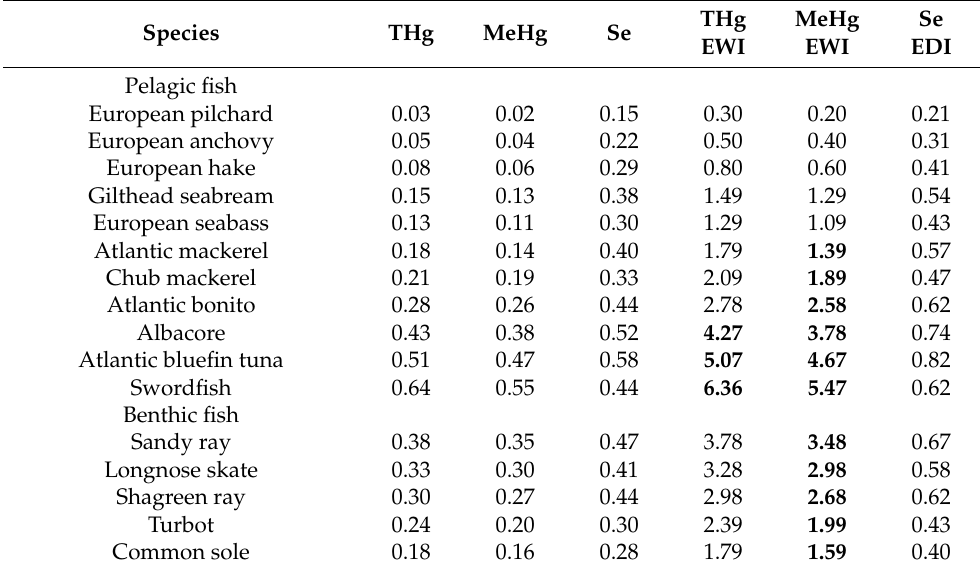
Table 2. Concentrations ( µ g g − 1 wet weight) and estimated intakes (EWI: µ g kg − 1 BW week − 1